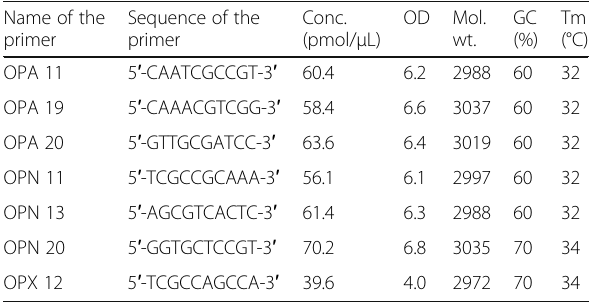
Table 2 Primer details used in RAPD analysis of different growth forms/sampling localities of D. strictus Name of the Sequence of the primer